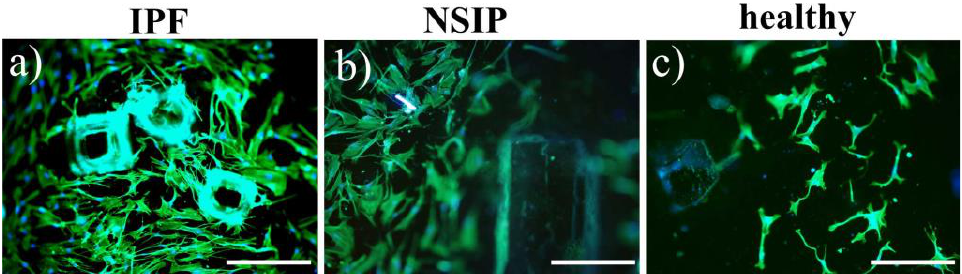
Figure 7. Fluorescence images of ( a ) IPF-, ( b ) NSIP-derived, and ( c ) healthy fibroblasts cultured on 3D PDMS structures prepared by adding sugar. The scale bar corresponds to 200 μ m (objective magnification 10×).